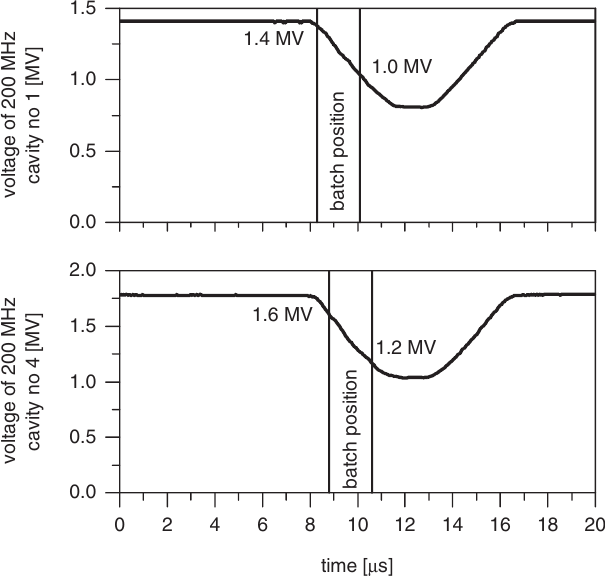
FIG. 4. Measured rf amplitude modulation in 200 MHz rf cavities of the SPS. All four cavities were modulated. SPS revolution time: 23 (cid:2) s The voltage increase after reaching FT, shown in Fig. 5, is necessary to match the bunches for transfer to the LHC. damping LHC type beams in the SPS: